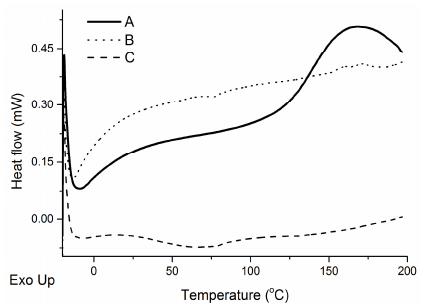
Figure 7. DSC curves of dried emulsions containing 200 mg of total monomer weight with 40 wt.% of tung oil ( A ) before post ‐ cure, ( B ) post ‐ cured at 140 °C for 1.5 h, and ( C ) post ‐ cured at 140 °C for 2 h.